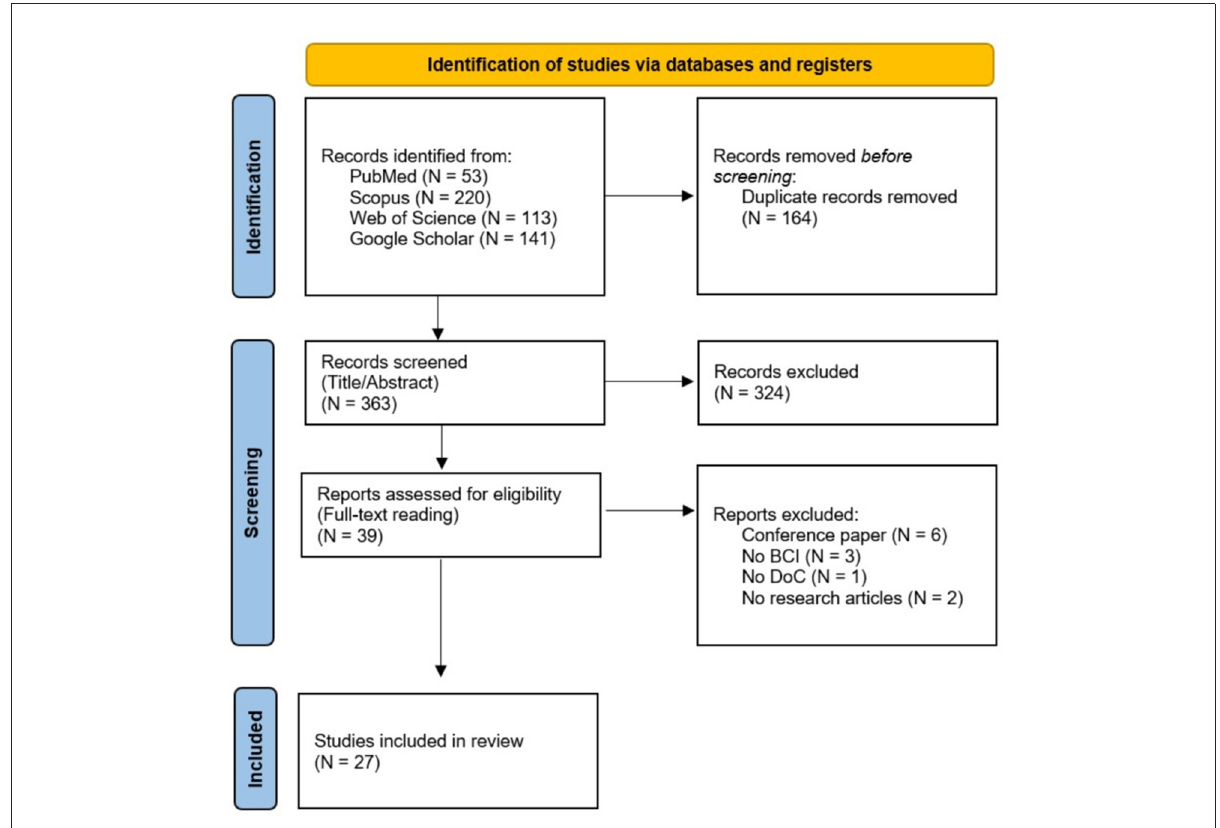
FIGURE1 PRISMA flow diagram of the selected